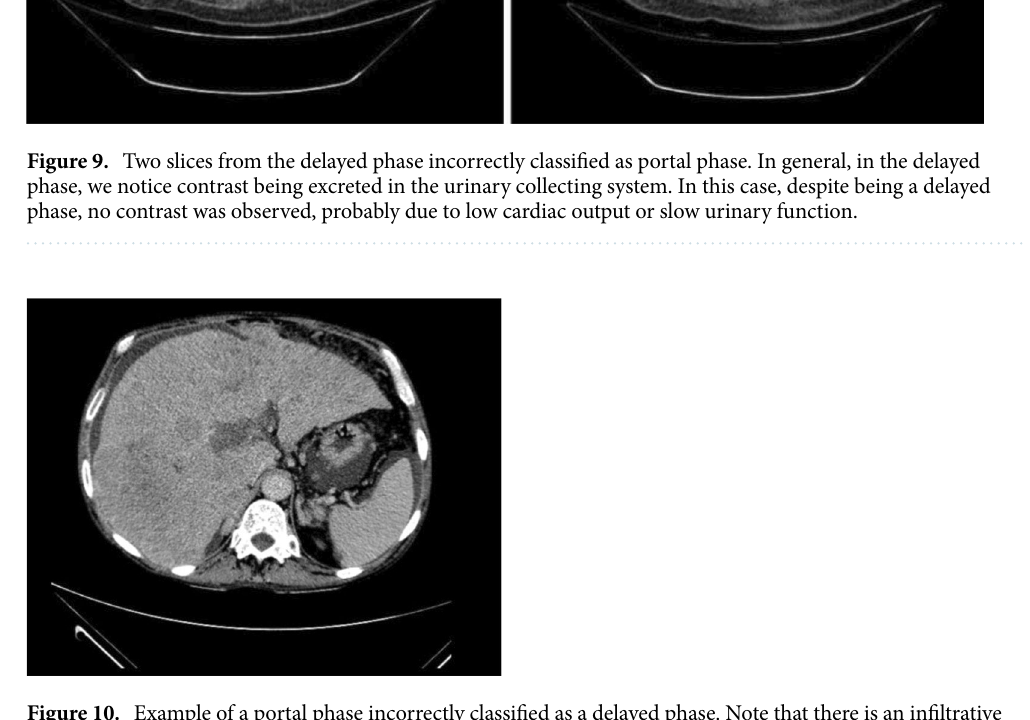
Figure 10. Example of a portal phase incorrectly classified as a delayed phase. Note that there is an infiltrative hepatocellular carcinoma with extensive portal vein